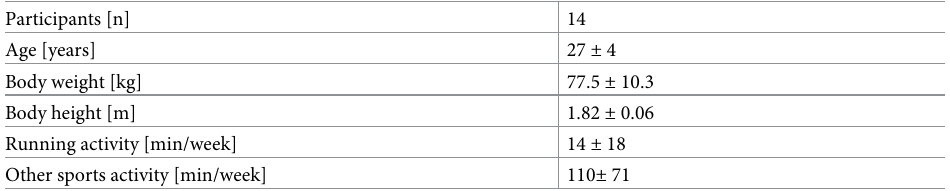
Table 1. Sample characteristics (mean ± standard